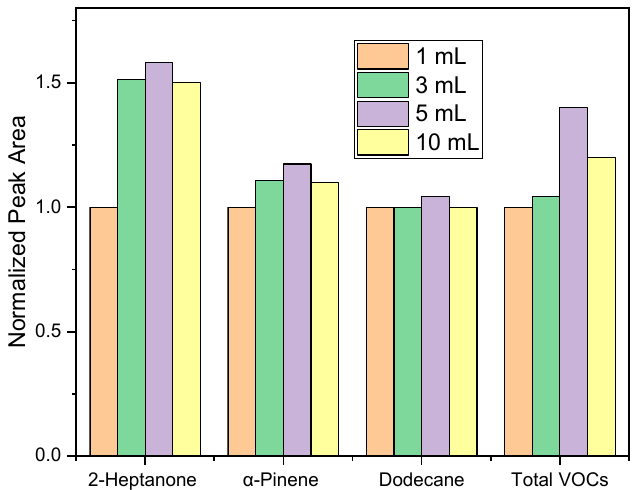
Figure 1. Evaluation of the sample volume for solid-phase microextraction (SPME) Arrow.